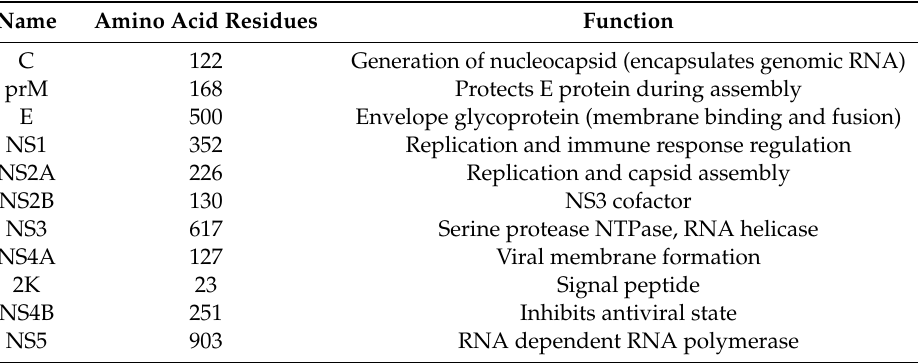
Table 1. The table shows the structural and nonstructural ZIKV proteins from the 5’ to the 3’ untranslated regions. The name, size in amino acids, and function are shown for each